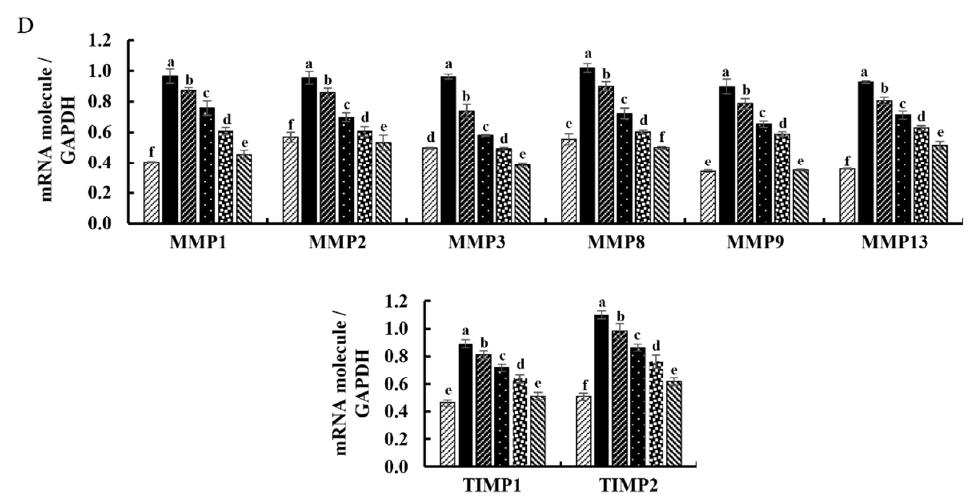
Figure 4. Inhibitory effect of FST on mRNA expression of inflammatory mediators, MMPs, and TIMP in TNF- α /IFN- γ -stimulated HDF cells. Effect of FST on ( A ) inflammatory cytokine expression, and ( B ) MMPs and TIMPs expression in TNF- α /IFN- γ -stimulated HDF cells evaluated by RT-PCR analysis. Densitometric analysis of ( C ) inflammatory cytokine expression, and ( D ) MMPs and TIMPs expression in TNF- α /IFN- γ -stimulated HDF cells. All experiments were performed in triplicate ( n = 3) to determine the repeatability and lettered error bars were significantly different within the same molecule ( p < 0.05).